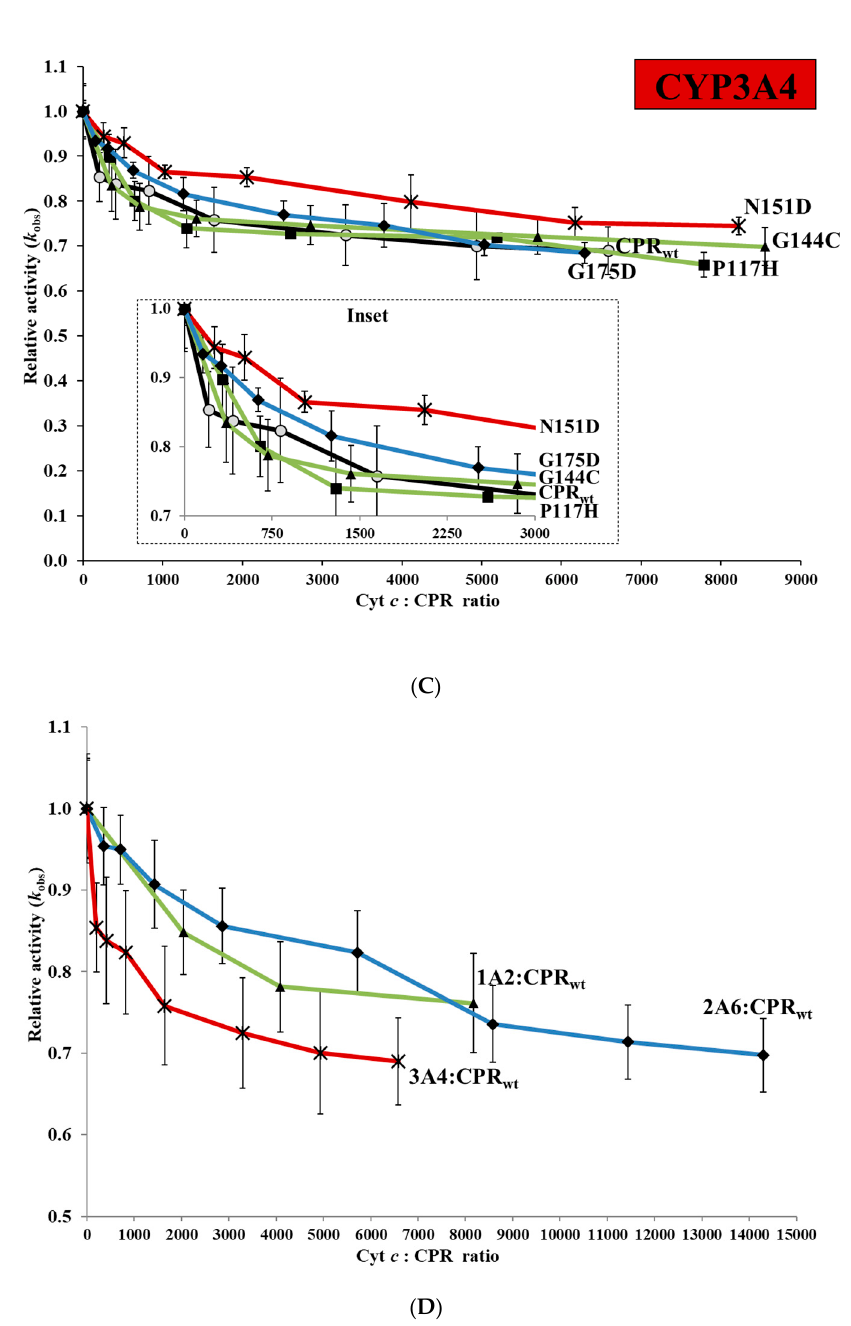
Figure 3. Relative CYP activities of the CPR ‐ FMN ‐ domain wildtype and four mutants plotted in function of the cyt c / CPR ratio. ( A ) CYP1A2 (EROD), ( B ) CYP2A6 (C7H), and ( C ) CYP3A4 (DBODF). Observed rate constants sustained by the CPR ( k obs ) were normalized by the CYP activity without cyt c [ k obs (0 nM cyt c ) ]. FMN wildtype (CPR wt :CYP, black lines). FMN mutants previously demonstrated to support a gain in CYP1A2 ‐ mediated EROD ‐ (P117H and G144C, green lines), CYP2A6 ‐ mediated C7H ‐ (G175D, blue lines), and CYP3A4 ‐ mediated DBODF ‐ activity (N151D, red lines). Normalized CYP activities represent the average of the three replicates and the error bars the standard deviation. Significant differences between the means of the activity profiles of CPR:CYP1A2 EROD ( p = 0.015) ( A ) and CPR:2A6 C7H ( p = 0.049) ( B ) were observed (ANOVA, one ‐ way analysis of variance). ( D ) CPR wt supporting CYP1A2 ‐ mediated EROD ‐ (green line), CYP2A6 ‐ mediated C7H ‐ (blue line), and CYP3A4 ‐ mediated DBODF ‐ activity (red line).